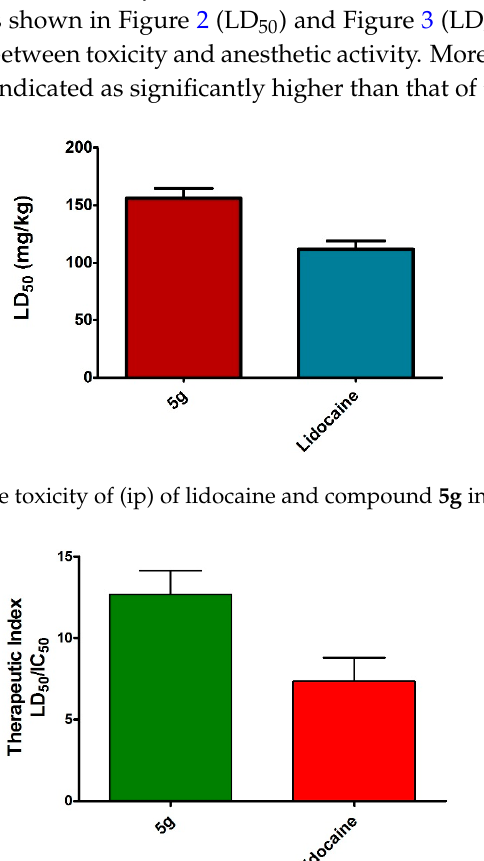
Figure 3. Therapeutic index of lidocaine and compound 5g evaluated as ratio between LD 50 and IC 50 (mouse tail test expressed in mg/kg).